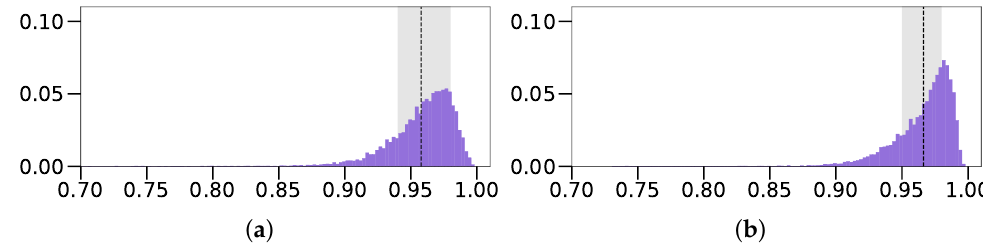
Figure 8. Distributions of IoU values obtained when training the model on regular depth images and on intensity images with the Fixed z position requirement. ( a ) Depth; ( b ) Intensity ( Fixed z